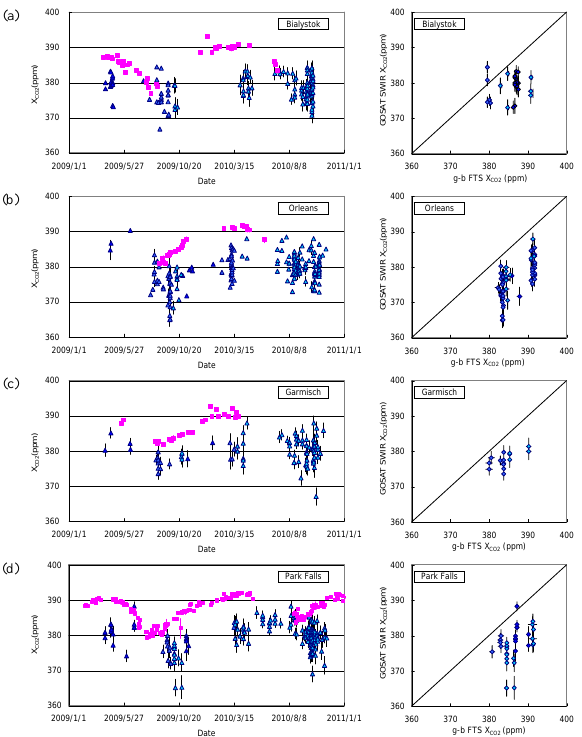
Fig. B1. Time series of GOSAT TANSO-FTS SWIR (blue trian- 7 gles) and g-b FTS (pink squares) X CO and their scatter diagrams 2 for (a) Bialystok, (b) Orl´eans, (c) Garmisch, (d) Park Falls, (e) La- mont, (f) Tsukuba, (g) Darwin, (h) Wollongong, and (i) Lauder. The GOSAT data were retrieved within ± 5 degrees latitude/longitude box centered at each g-b FTS site and the g-b FTS data were the mean values measured within ± 1 h of GOSAT overpass time.